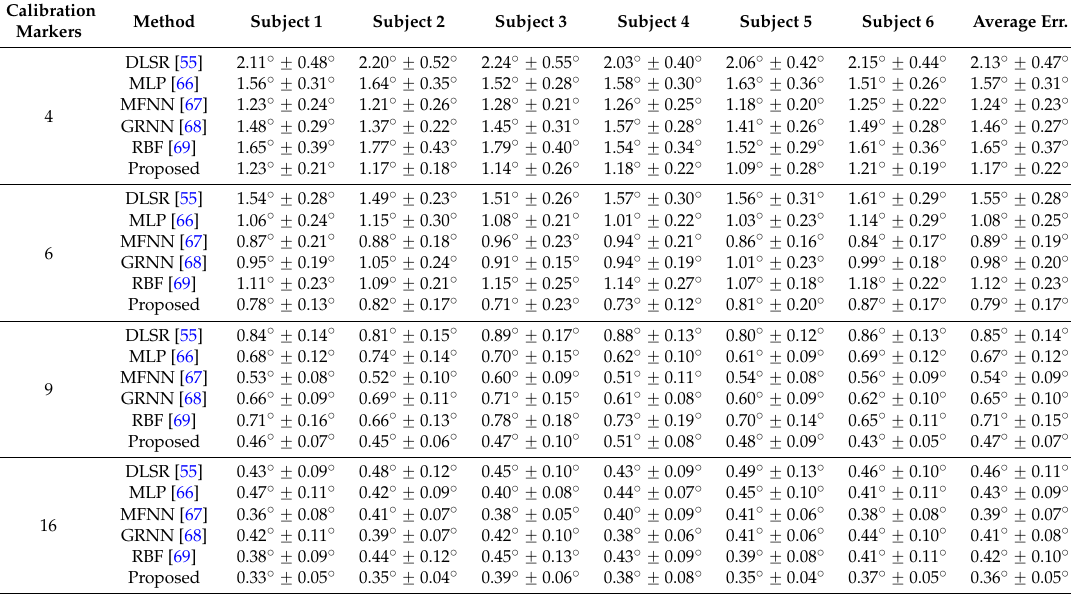
Table A2. Comparison of gaze estimation accuracy between proposed method and other NN methods considering error